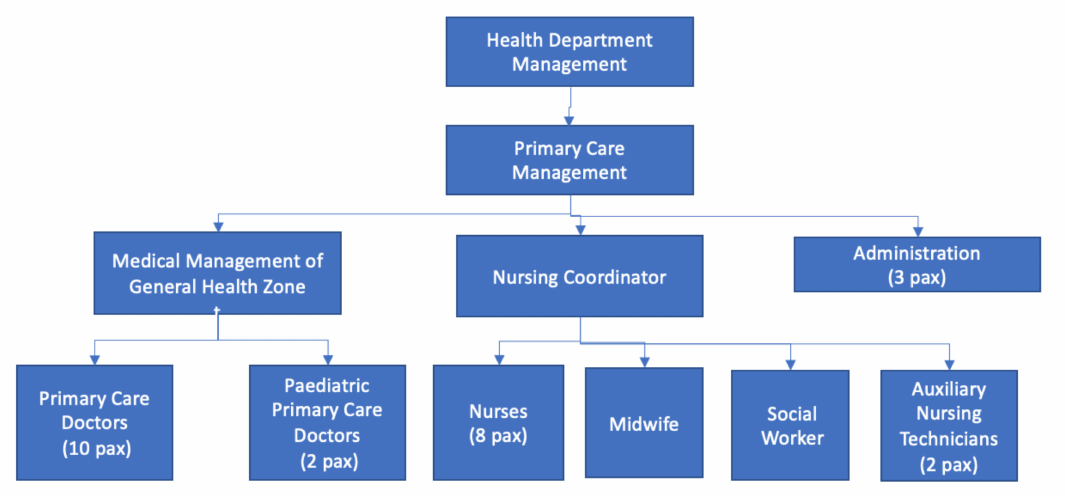
Figure 3. Health center organization chart.